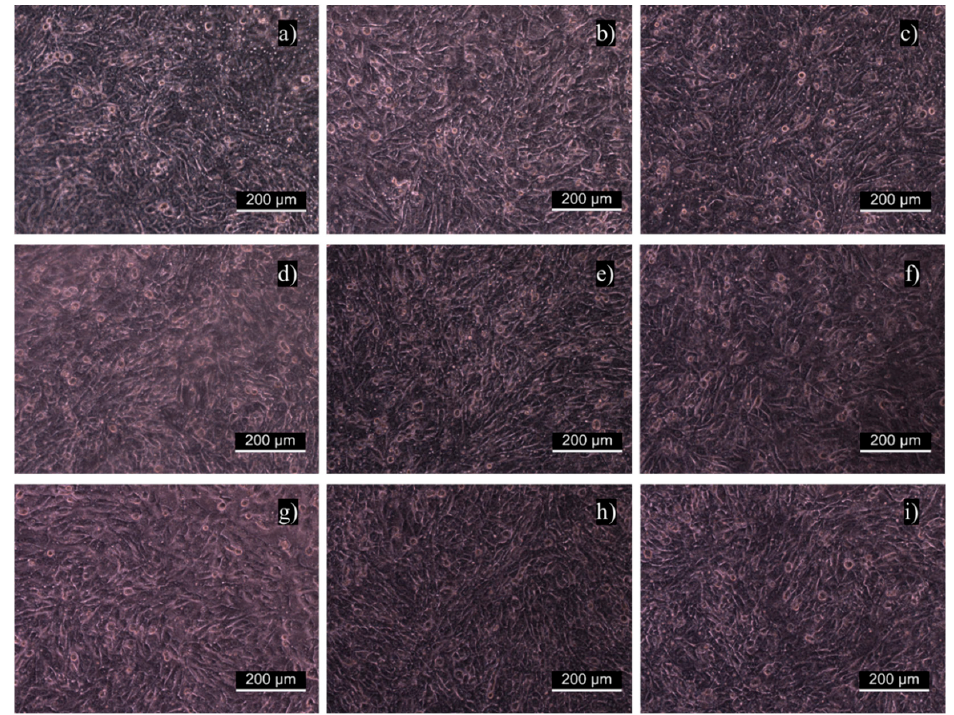
Figure 4. Fibroblast proliferation on examined samples: ( a ) untreated PET, ( b ) PET_DC, ( c ) DC_MAAM, ( d ) MAAM_1000, ( e ) MAAM_8500, ( f ) MAAM_KAPA, ( g ) DC_1000, ( h ) DC_8500 and ( i )